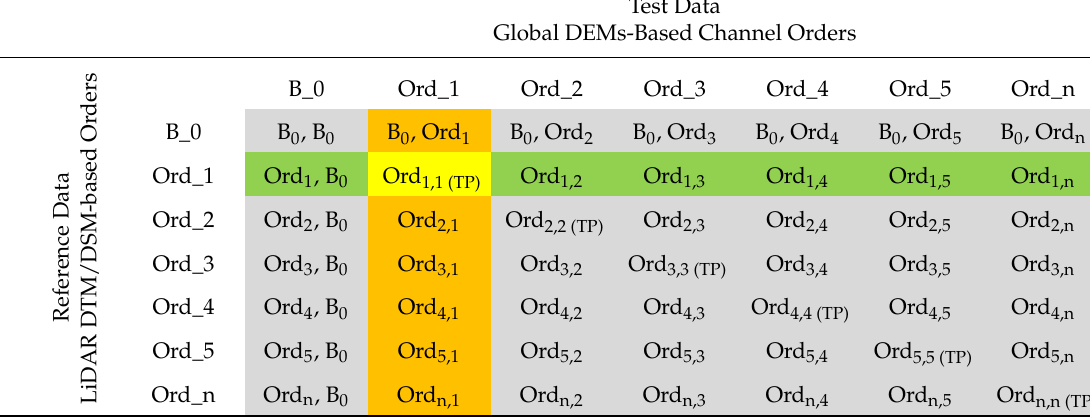
Table 3. Outputs of multiclass error matrix resulting from comparing a LiDAR DTM/DSM (reference data)-derived channel orders and a global DEM (test data)-based orders with a channel having a higher order of n; where Ord denotes channel order and B 0 refers to the background of 0